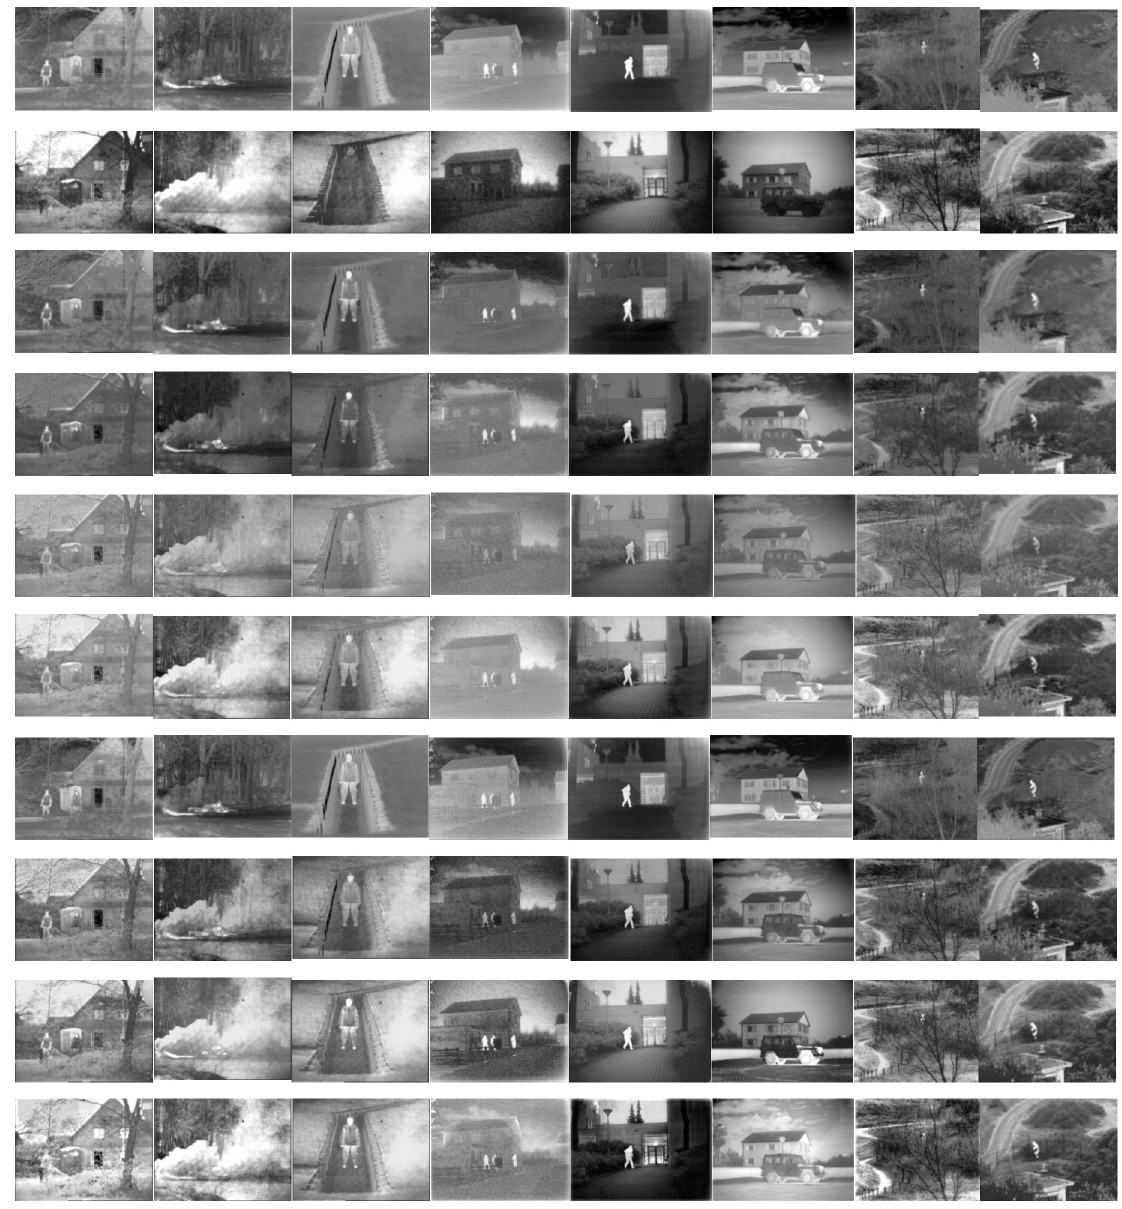
Fig 10. Qualitative fusion results for eight typical infrared and visible image pairs from the TNO database. (The first row: Infrared images; The second row: Visible images; The third row: FusionGAN; The fourth row: GANMcC; The fifth row: MDLatLRR; The sixth row: NestFuse; The seventh row: RESNetFusion; The eighth row: SEDRFuse; The ninth row: STDFusionNet; The tenth row: